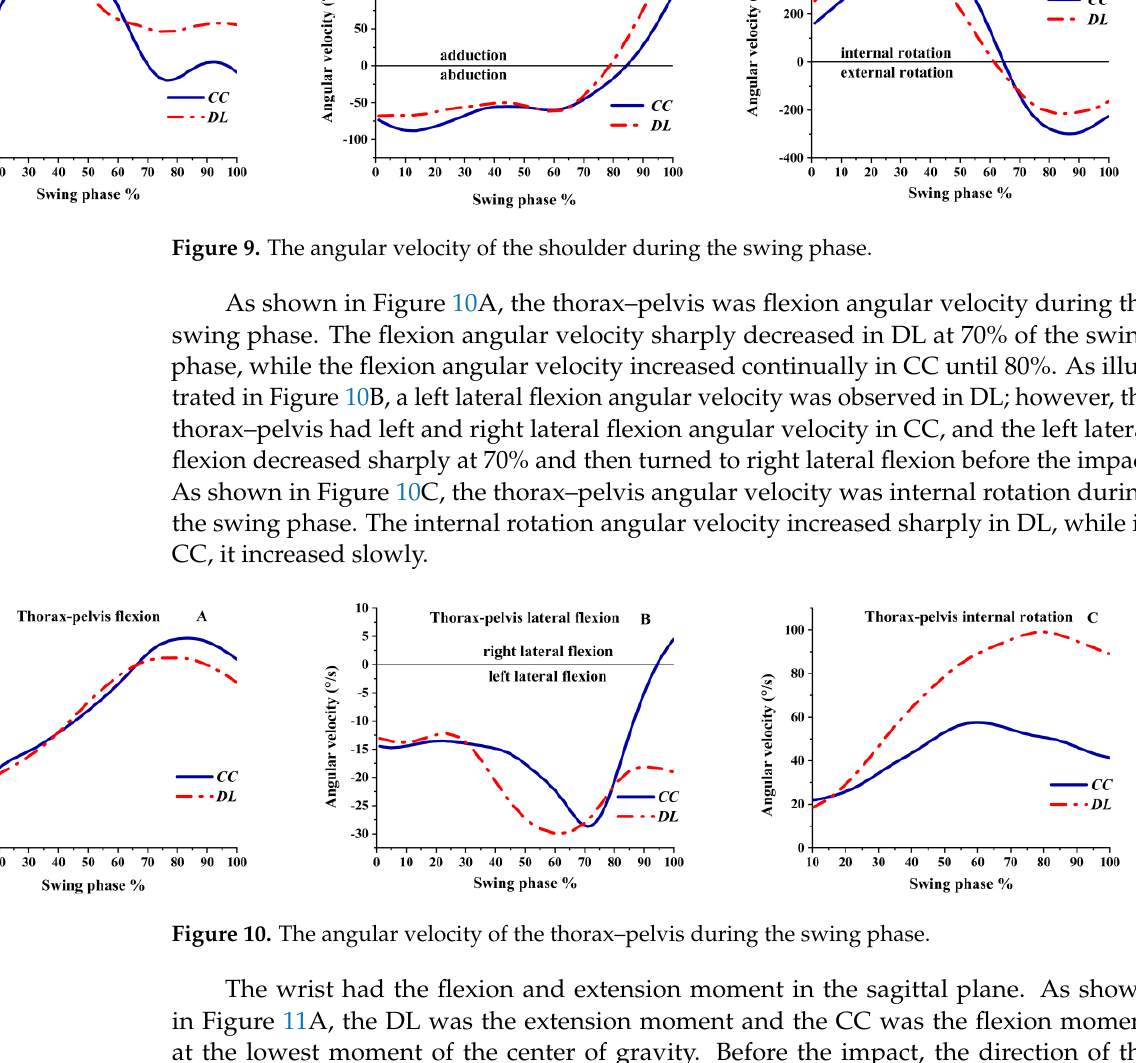
Figure 11. The moment of wrist joint during swing phase.